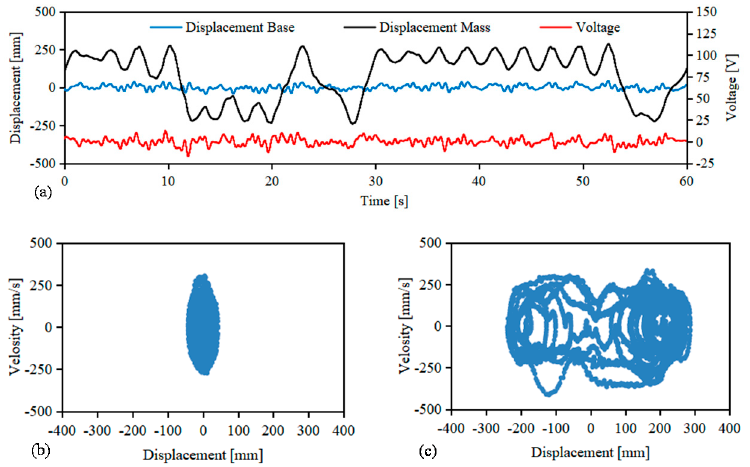
Figure 19. Measurement results of response vibration displacement and vibration power generation when vibrating with a random signal and a period signal 0.45 Hz of middle amplitude 20 mm. ( a ) Results of response vibration displacement. ( b ) Diagram of displacement velocity of vibration of the support. ( c ) Diagram of displacement velocity of vibration of the mass block.